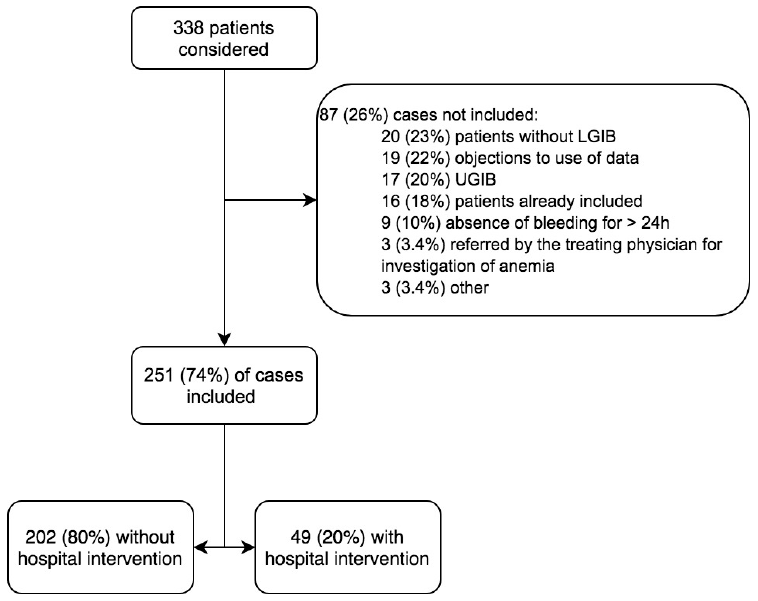
Figure 1. Flowchart. LGIB: lower gastrointestinal bleeding; UGIB: upper gastrointestinal bleeding. Table 1. Patient characteristics.